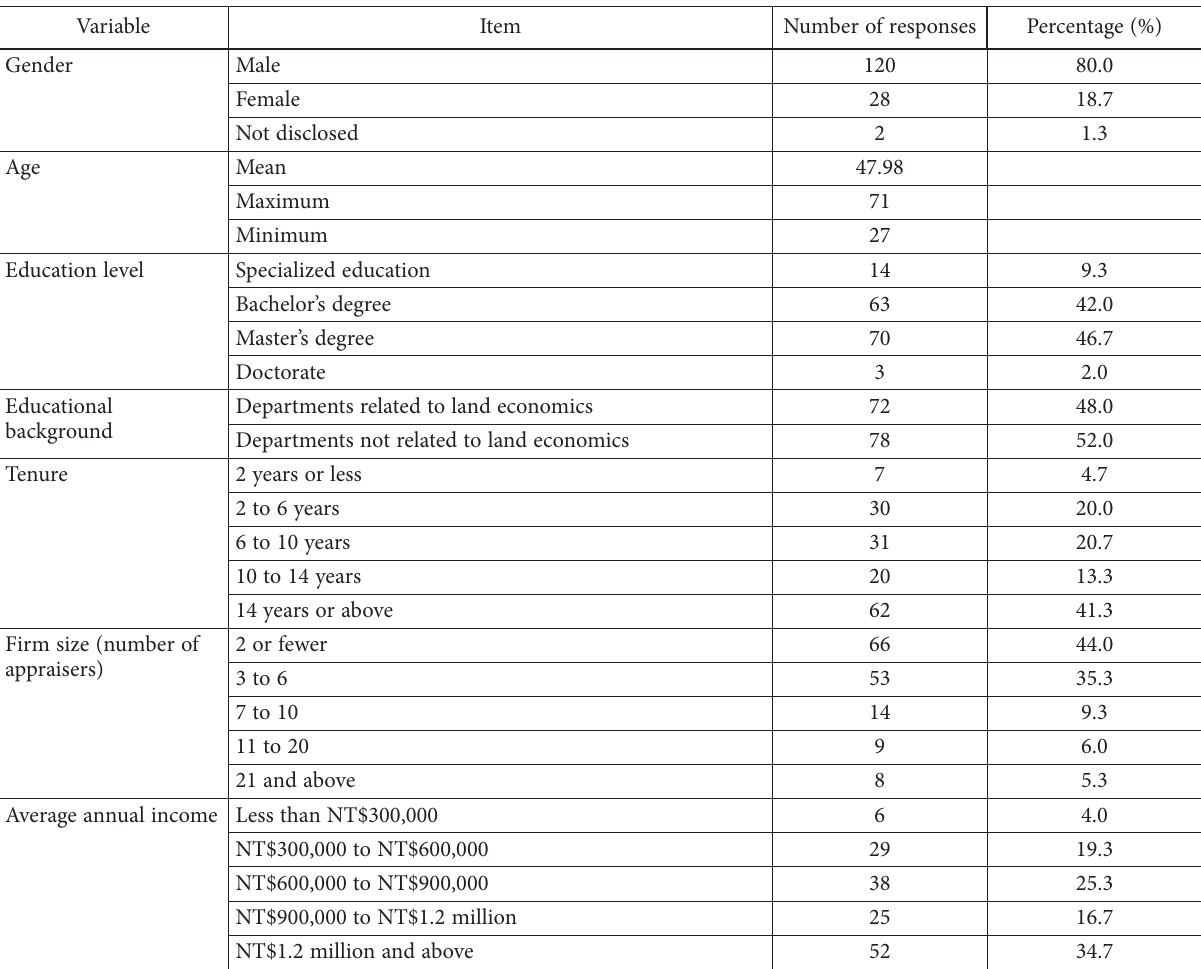
Table 2. Descriptive statistics of the